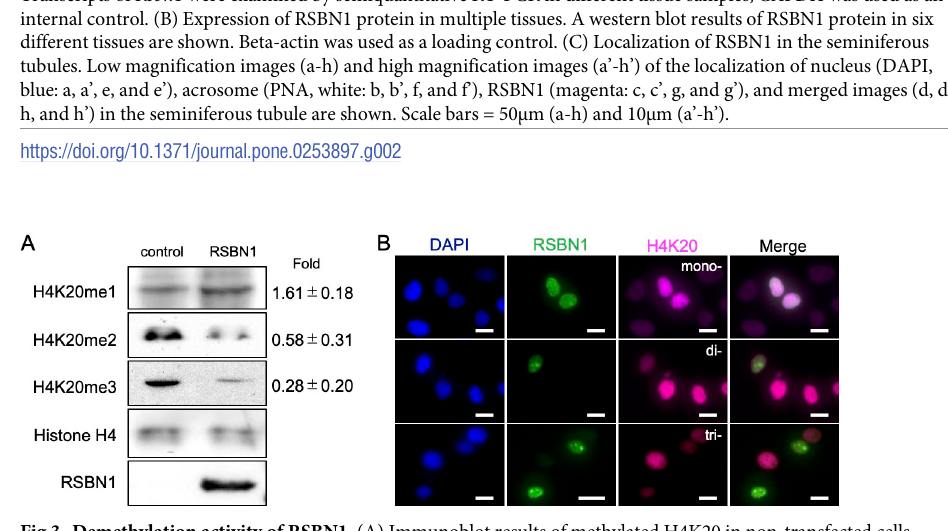
PLOS ONE | https://doi.org/10.1371/journal.pone.0253897 June 29,